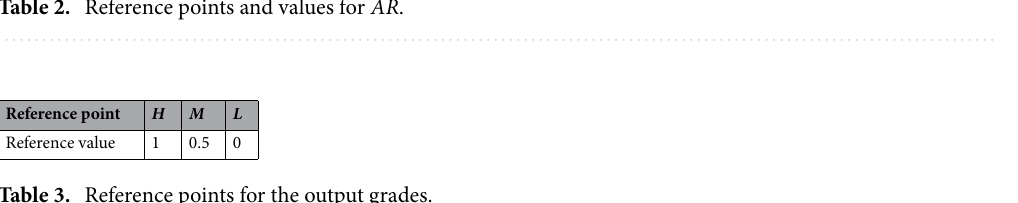
Table 3. Reference points for the output